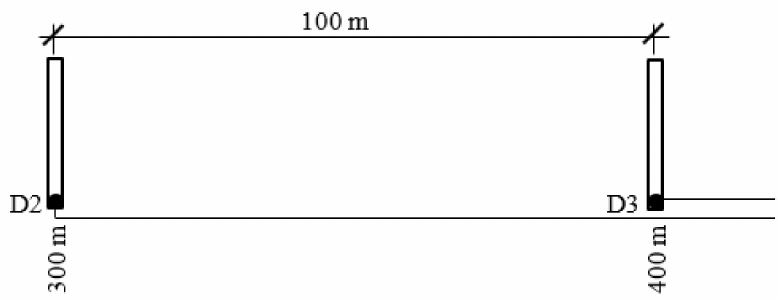
Figure 13. Steel strips with accelerometers D2 and D3 at a distance of 100